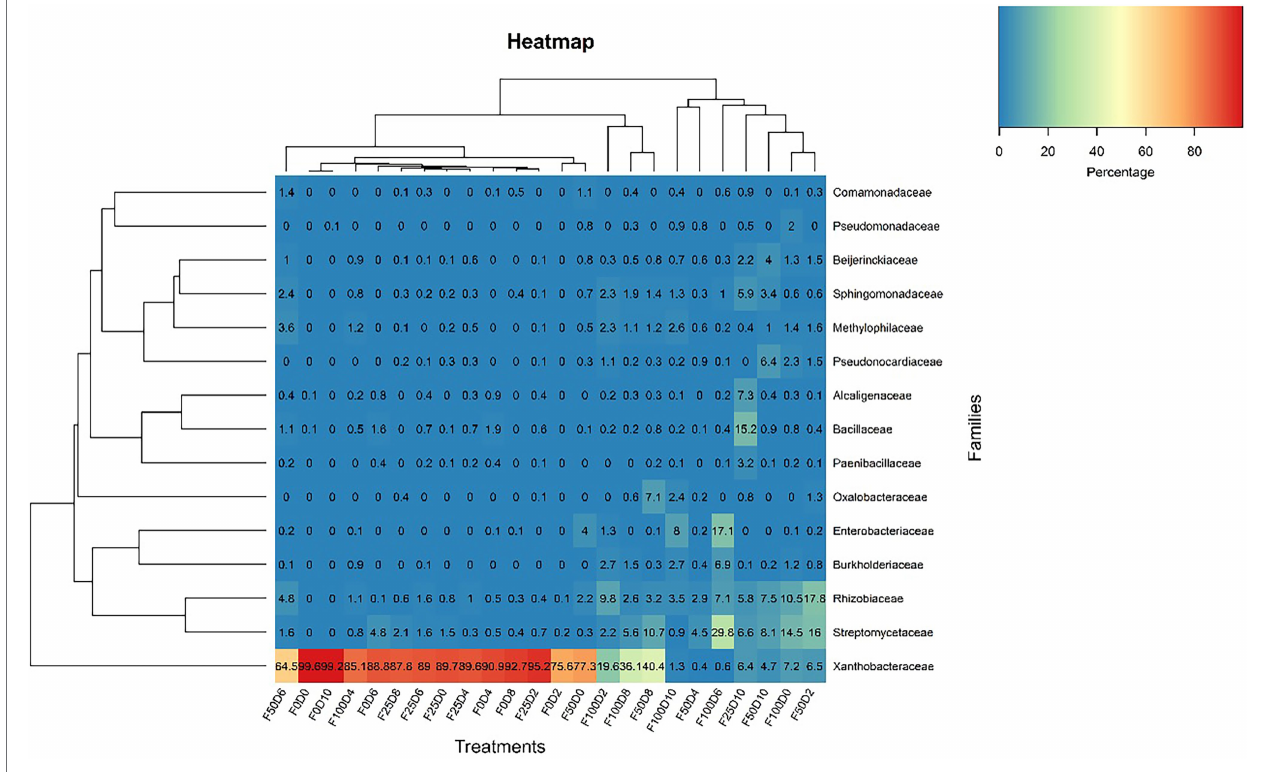
FIGURE 8 | Heatmap clustering with the most abundant ASVs at the family level considering all 24